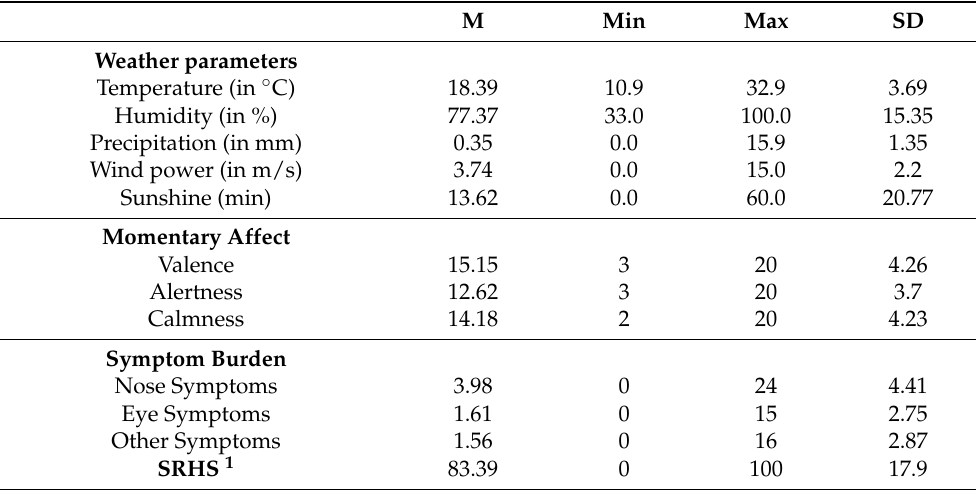
Table 1. Descriptive statistics of environmental (weather) parameters, momentary affect, health status and symptom burden of seasonal allergic rhinitis.